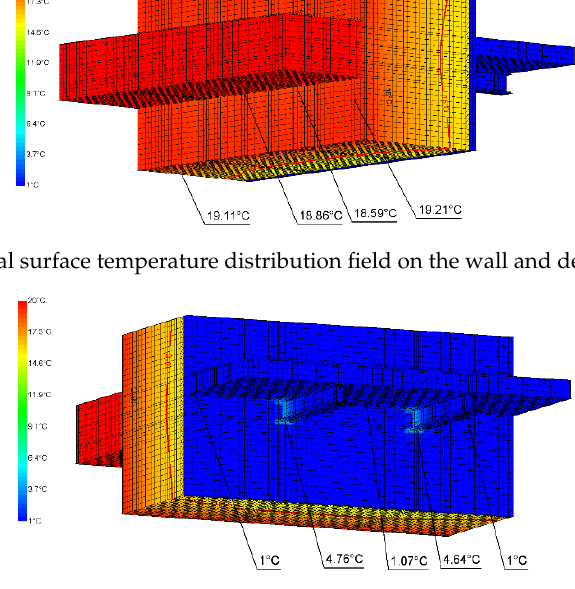
Table 3. Comparison of analysis results for the temperature underneath the cantilevers supporting the building’s balconies, obtained using a thermal vision camera.